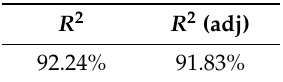
Table 12. Model Summary.